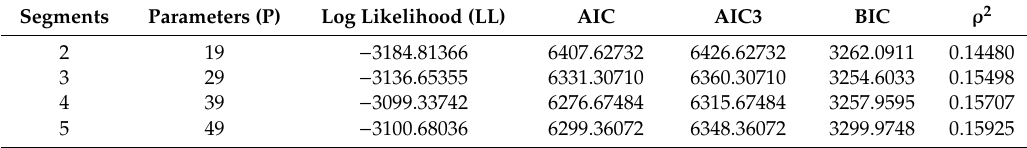
Table 4. Statistics to determine the optimal number of consumer segments.